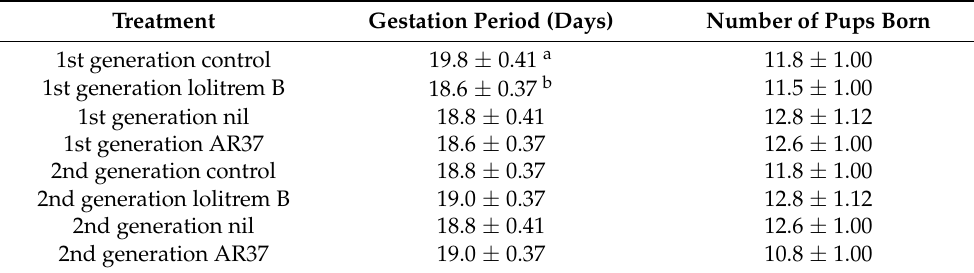
Table 10. Gestation period and pups born/litter for mice fed diets containing lolitrem B (1.06 ppm) or AR37 seed (30%) for 2 generations.